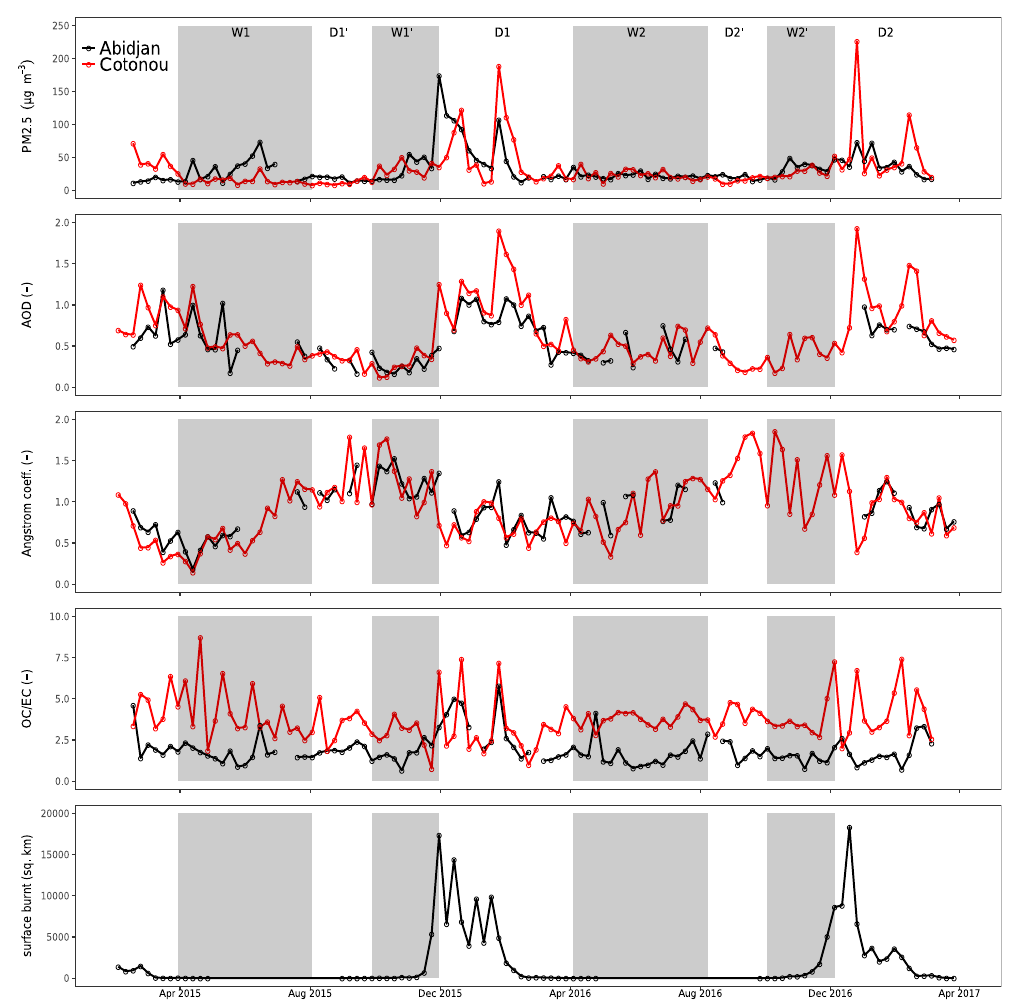
Figure 7. Weekly mean PM 2 . 5 , AOD, Ångström exponent and OC / EC ratio observed at Cotonou and Abidjan traffic sites from Febru- ary 2015 to March 2017. The surface burnt is the weekly total of the MODIS MCD64A1 product burnt surface areas for the region from 7 ◦ W to 4 ◦ E and 4 to 10 ◦